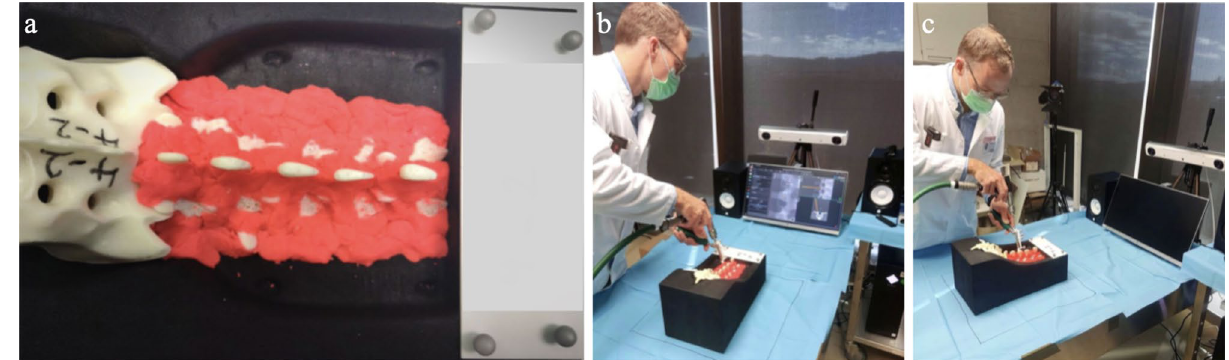
Figure 4. The experiment setup, ( a ) the phantom covered with Play-Doh, ( b ) task assisted with visualization, ( c ) task assisted with